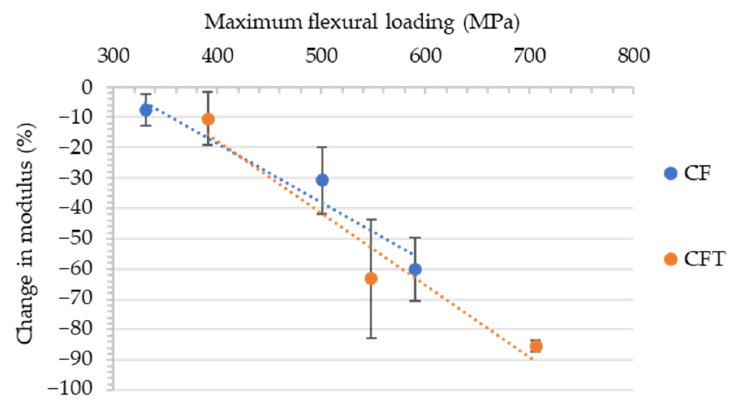
Figure 7. Cyclic loading of CFRP and CFRP veil toughened with PA 6,6 for 100,000 cycles at 50, 70, and 90% maximum flexural strength. Designated CF and CFT for the control CFRP and veil tough ‐ ened control CFRP, respectively. Samples individual loading for CF is 330 MPa, 500 MPa, and 544 MPA and CFT loaded at 390 MPa, 550 MPa, and 705